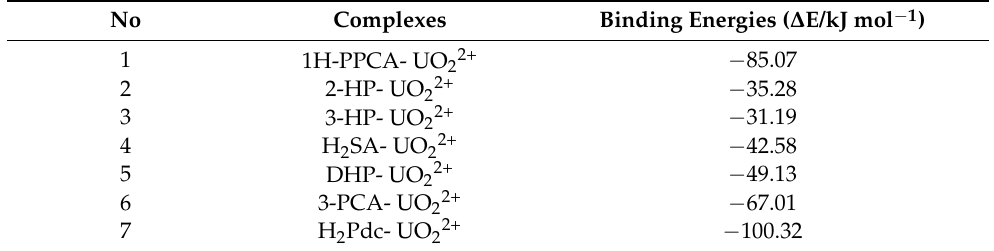
Figure 2. Optimized conformation of UO 22+ and functional binding ligand. Table 1. Binding energy ( ∆ E) of functional binding ligand complexes of different template